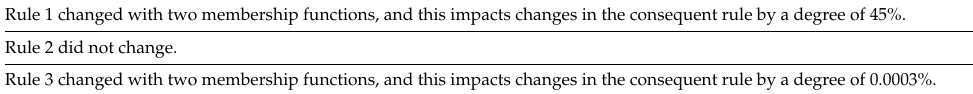
Table 1. Interpretability concerning (degree of) changes in fuzzy neurons during the evolution phase. Rule 1 changed with two membership functions, and this impacts changes in the consequent rule by a degree of 45%. Rule 2 did not